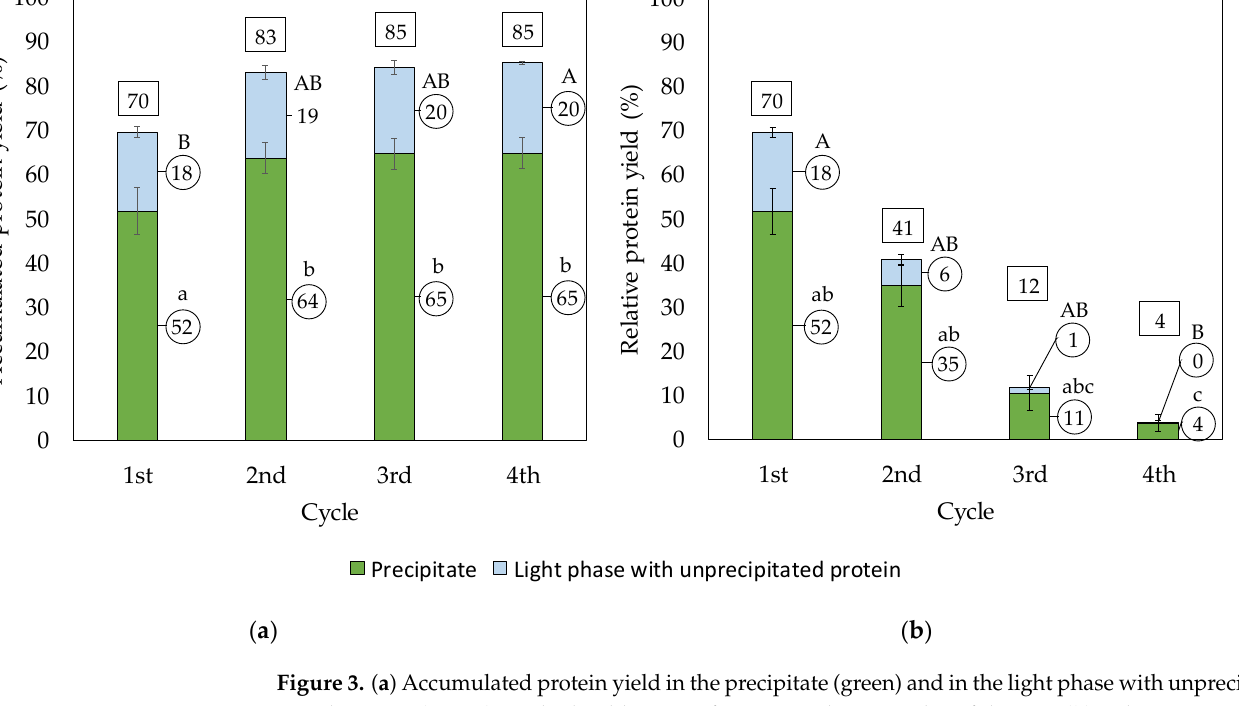
Figure 3. ( a ) Accumulated protein yield in the precipitate (green) and in the light phase with unprecipitated protein (LPUP ) marked in blue over four recirculation cycles of the SSF. ( b ) Relative protein yield showing how large a proportion of the protein in the starting material in each recirculation run was measured in the precipitate (green) and in the LPUP (blue). Different uppercase letters indicate significant differences between LPUP and different lowercase letters indicate significant differences between precipitates, p ≤ 0.05.